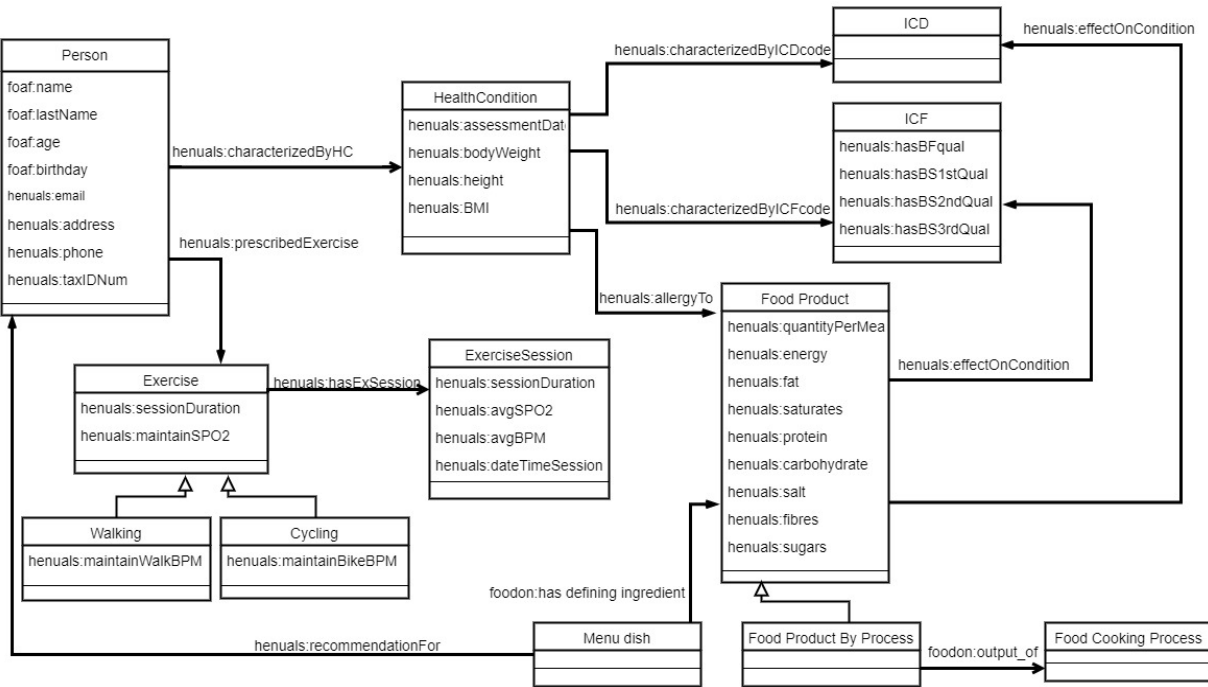
Figure 2. A UML representation of the HeNuALs ontology layer. OWL classes are represented as UML classes, datatype properties are represented as UML attributes, and object properties are represented as UML associations among classes.